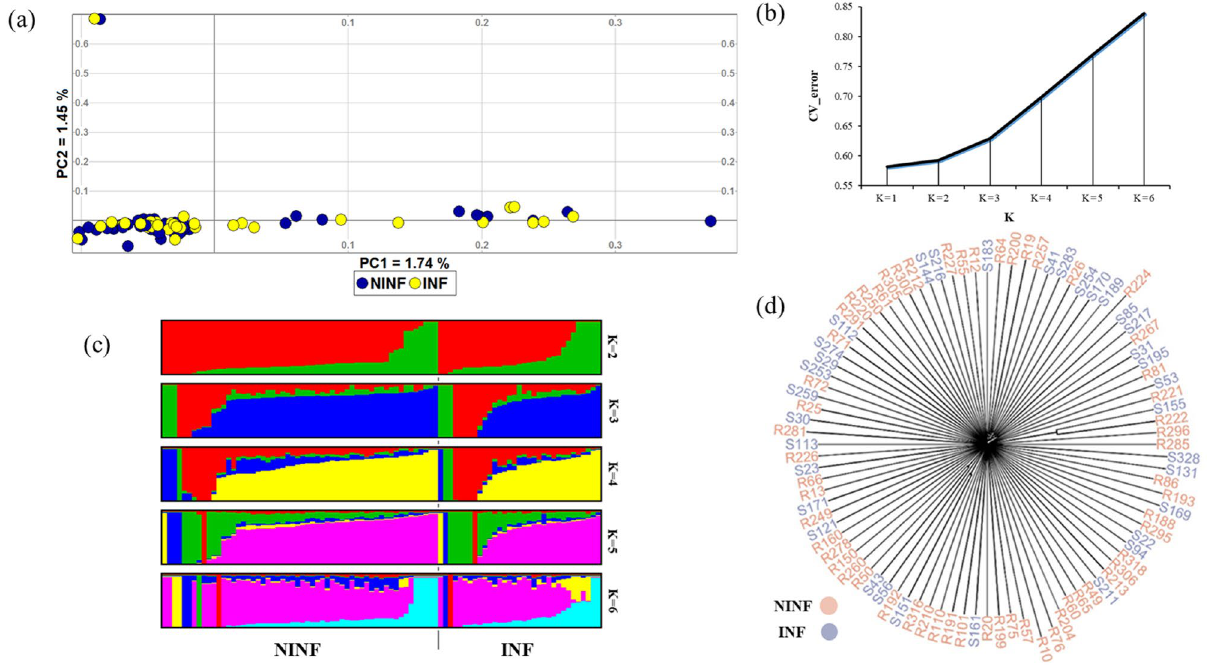
Figure 2. Population genetic structure and phylogenetic analysis of the two cohorts of autochthonous Tunisian sheep ( a ) PCA cluster analysis showing PC1 and PC2; ( b ) Cross-validation plot for admixture analysis; ( c ) Admixture analysis plot showing the genetic backgrounds present in the study cohorts for 2 ≤ K ≤ 6; ( d ) ASD phylogenetic tree of individuals of the study population. INF infected cohort; NINF non-infected cohort.